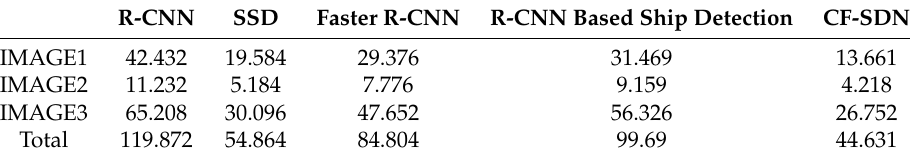
Table 4. Performance comparison of the five methods on the testing set in terms of time(unit: second).